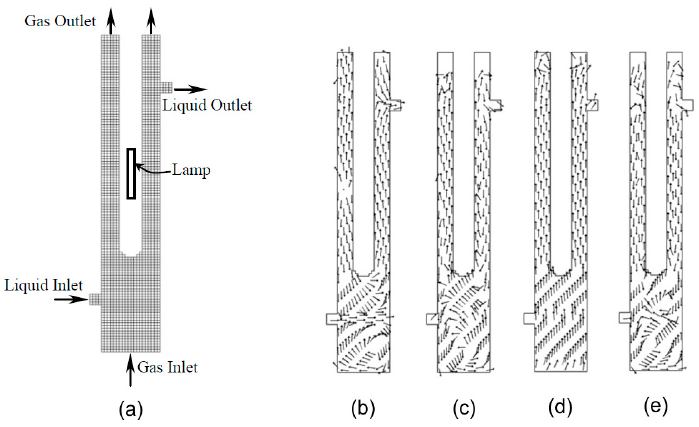
Figure 3. Three-phase CFD hydrodynamic modeling: ( a ) a cross-section of the 3D computational domain and grid; ( b ) liquid velocity vectors in the absence of airflow; ( c ) liquid velocity vectors with gas flow; ( d ) gas velocity vectors; and ( e ) TiO 2 particle velocity vectors. Adopted with permission from [42]. Copyright Elsevier,